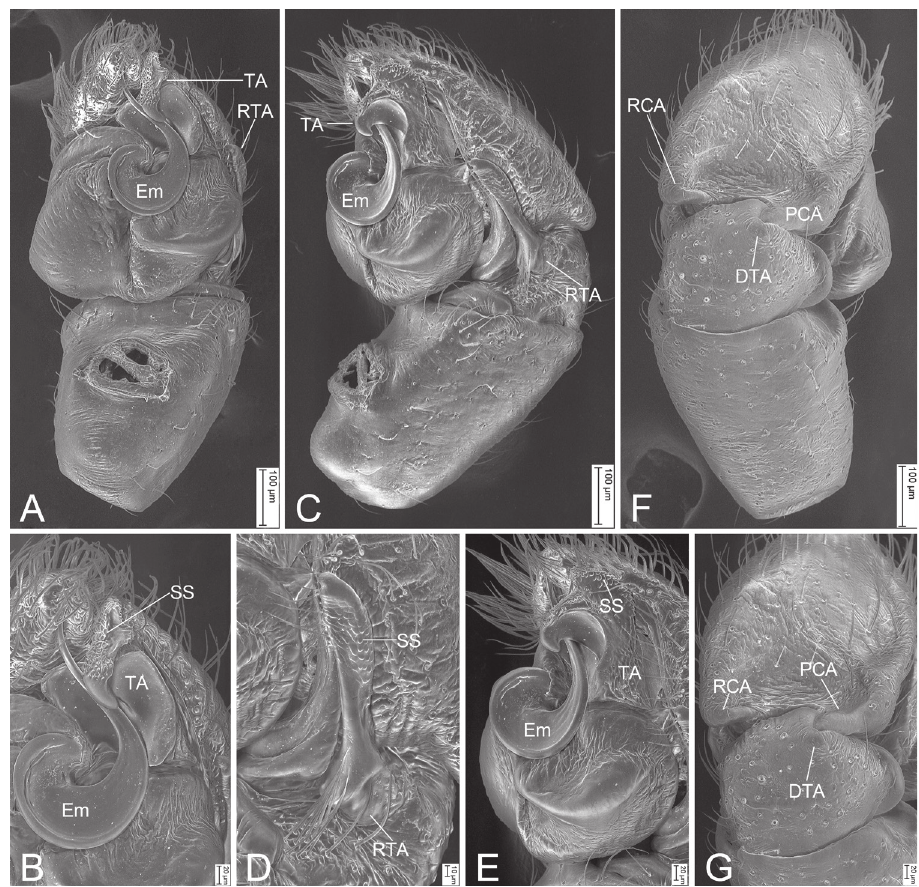
Figure 5. Synagelides jinding sp. nov., SEMs of holotype male A palp, ventral view B same, detail of terminal apophysis and embolus, ventral view C same, retrolateral view D same, detail of retrolateral tibial apophysis, retrolateral view E same, detail of terminal apophysis and embolus, retrolateral view F same, dorsal view, slightly prolateral G same, detail of postero-prolateral cymbial apophysis, postero-retrolateral cymbial apophysis and dorso-prolateral tibial apophysis, dorsal view. Abbreviations: DTA – dorso-prolater- al tibial apophysis, Em – embolus, PCA – postero-prolateral cymbial apophysis, RCA – postero-retrolateral cymbial apophysis, RTA – retrolateral tibial apophysis, SS – scale-like serrations, TA – terminal